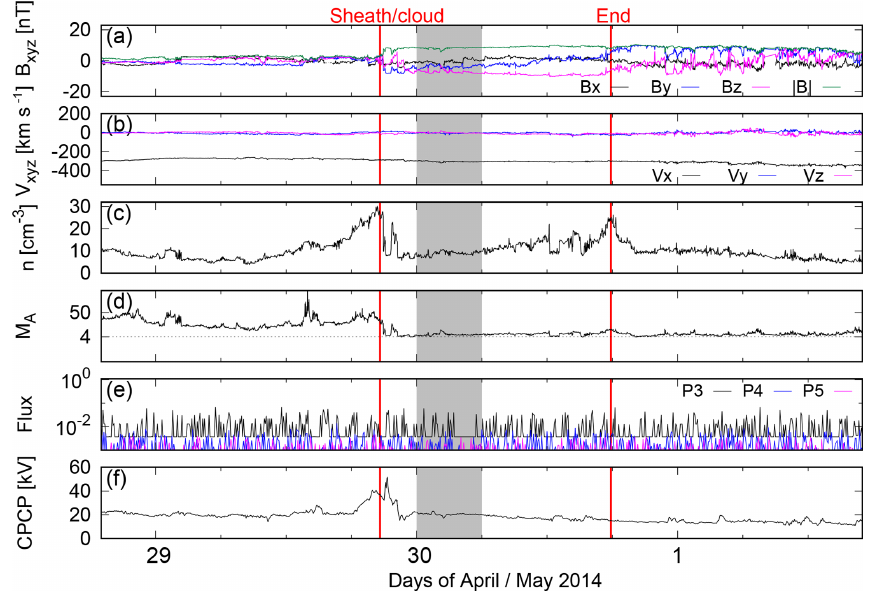
Figure 2. Solar wind and IMF conditions during 28 April 19:00UT–1 May 17:00UT, 2014. Panels from top to bottom: (a) IMF components B X , B Y and B Z and the IMF magnitude in nT, (b) plasma velocity components V X , V Y and V Z in kms − 1 , (c) plasma number density n in cm − 3 , (d) upstream Alfvén–Mach number M A ( M A = 4 is marked with a dotted line), (e) GOES-15 geostationary orbit proton fluxes for three energy channels between 8 and 80MeV, and (f) the ionospheric cross-polar cap potential from GUMICS-4. Data in panels (a) – (d) are measured by ACE/Wind. Vertical red lines indicate the onset of the ICME sheath/magnetic cloud or the end of the ICME event. Grey background shows the part of the ICME event that is simulated using both 0.25 and 0.5 R E as a maximum spatial